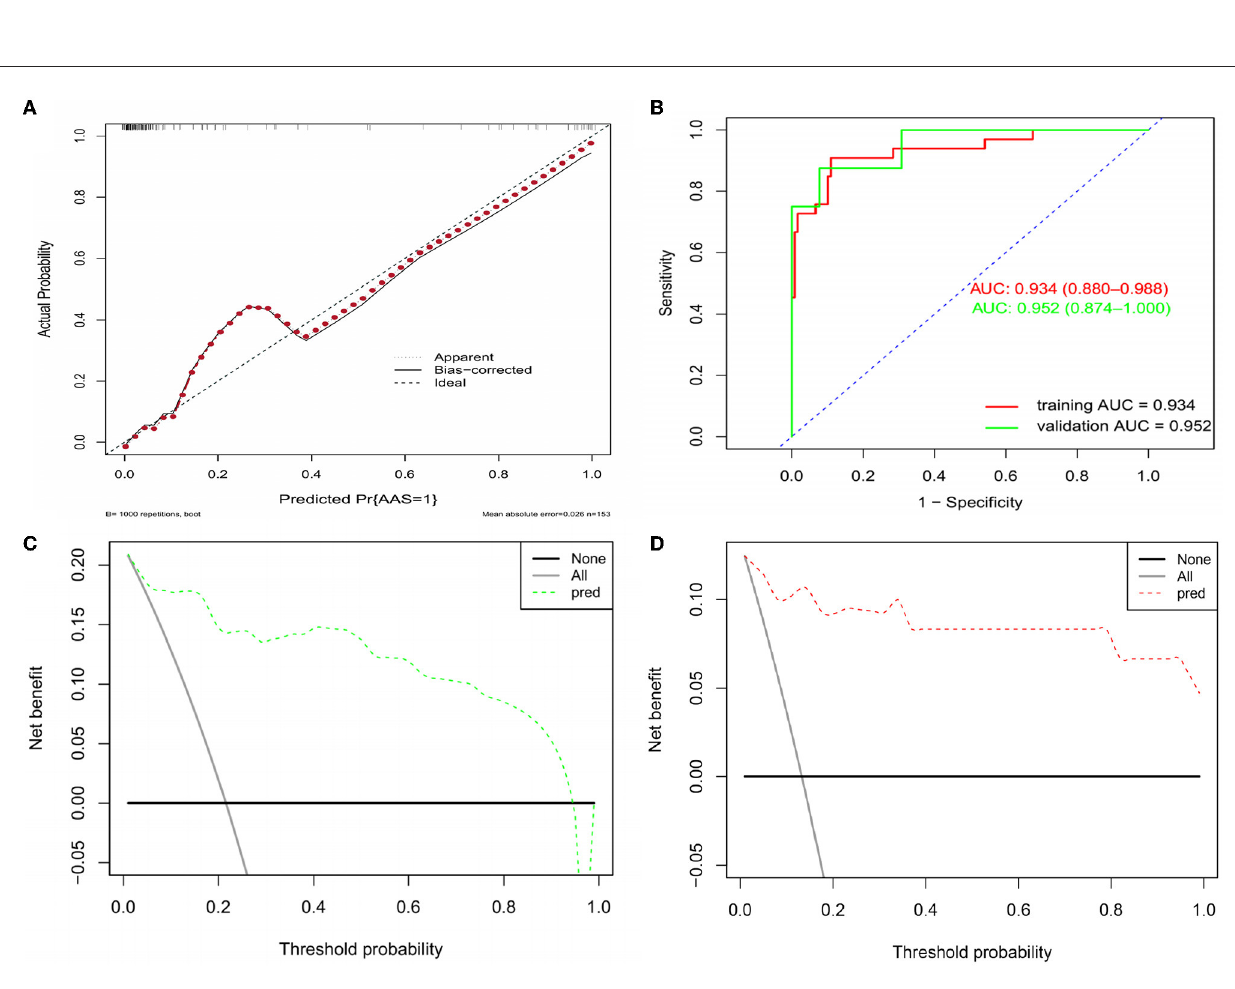
FIGURE3 Assessment and validation of the nomogram model. (A) Calibration plot in the training set. (B) ROC curves in both the training and validation sets. (C) Decision curve in the training set. (D) Decision curve in the validation set. AUC, areas under the curve; ROC, receiver operating